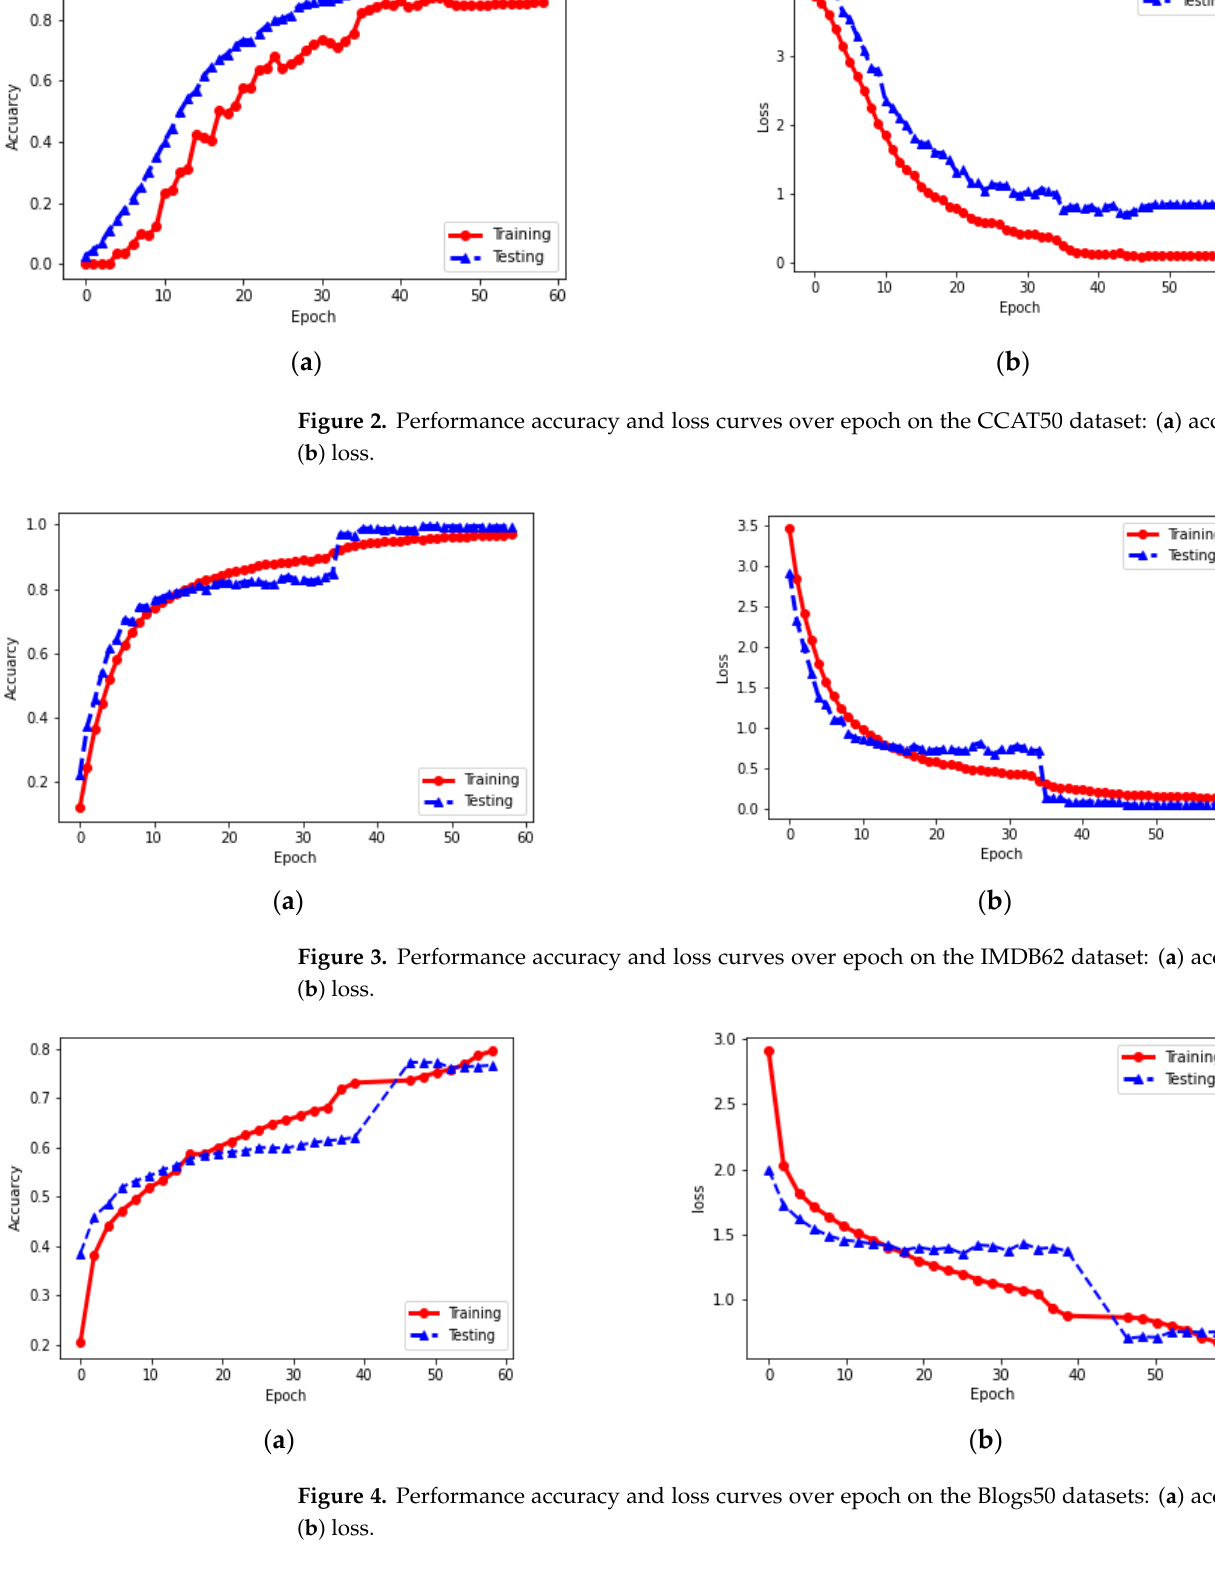
( b ) Figure 5. Performance accuracy and loss curves over epoch on the Twitter50 dataset: ( a ) accuracy, ( b ) loss. The performance of the RDNN method was further tested to determine how author number and post length increased with fewer iterations for all the experimental datasets. Figure 6 demonstrates how the RDNN method performs in comparison to the SOTA methods on CCAT50 and IMDB62 datasets. The RDNN method has superior accuracy in